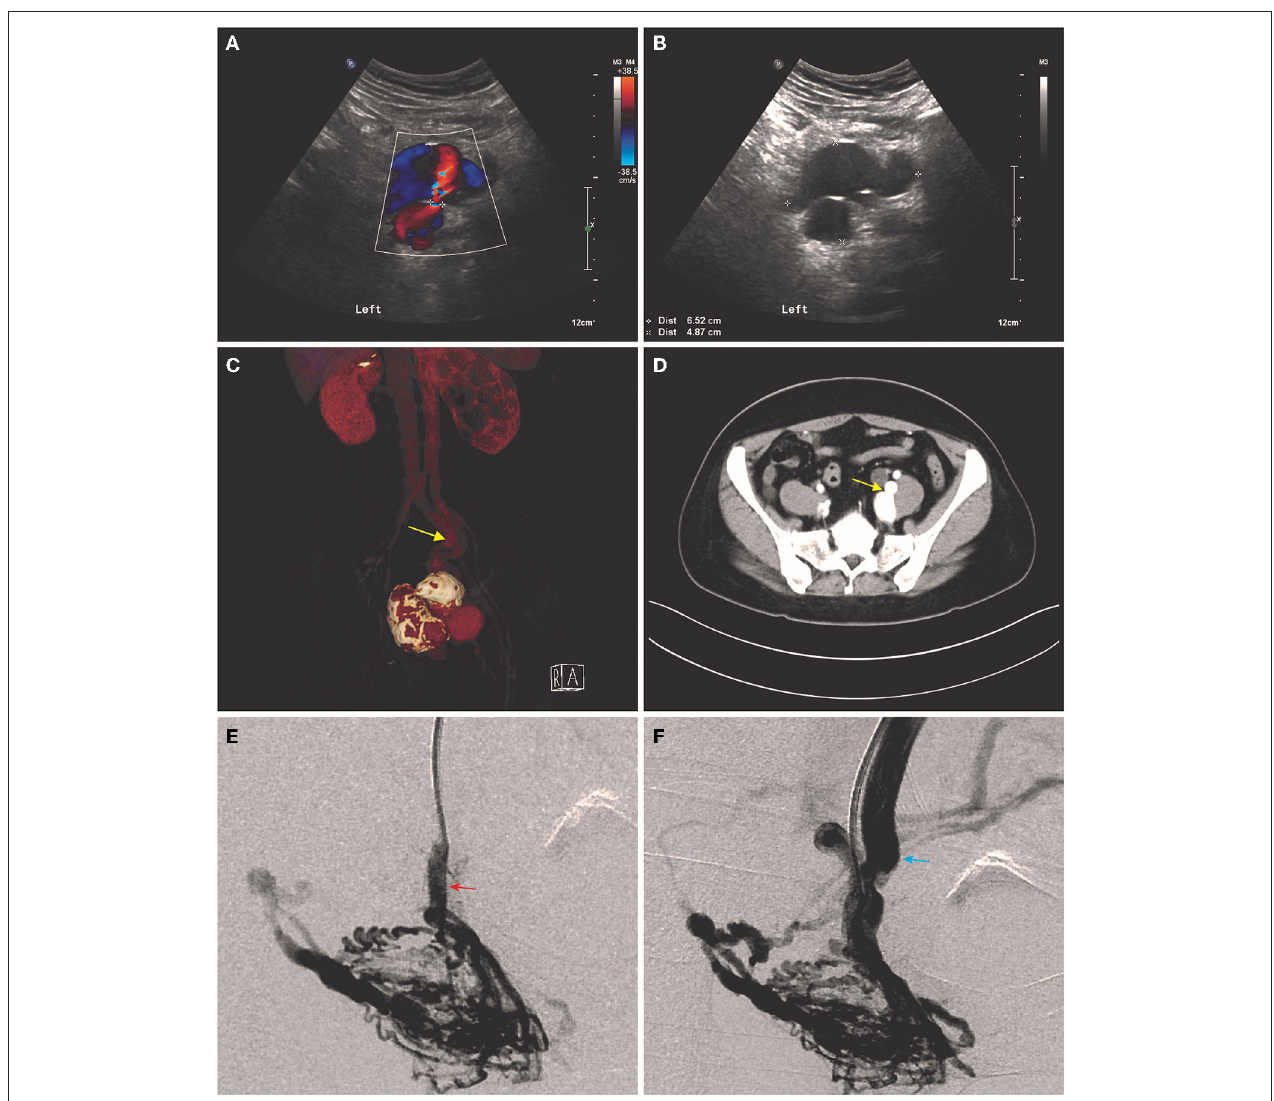
FIGURE 1 | Typical imaging presentations of iliac arteriovenous fistulas (IAVFs). (A) Multicolored blood flow can be seen in the proximal artery during both the systole and diastole in ultrasound. (B) Aneurysm and venous aneurysm formation were shown in ultrasound. (C,D) CT angiography (CTA) and cross-sectional image showed a direct connection (yellow arrows) between internal left iliac artery and vein accompanied with aneurysm and venous aneurysm formation. (E,F) . Digital subtraction angiography (DSA) showed multiple connections between a branch of inflow left iliac artery (red arrow) and outflow left internal iliac vein.